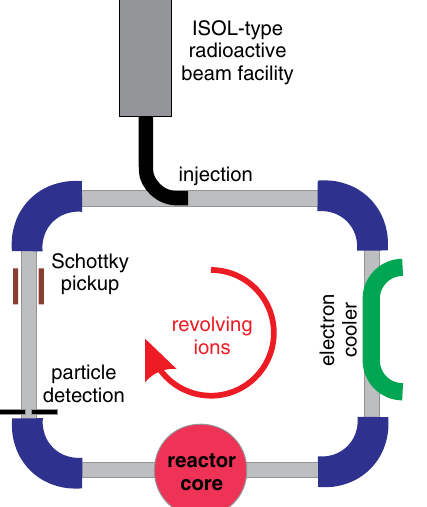
FIG. 1 (color online). Schematic drawing of the proposed setup. Shown are the facility to produce and separate exotic nuclei of interest (dark gray) and the main components of an ion storage ring which include the beam lines and focusing elements (gray), dipoles (dark blue), electron cooler (green), an intersected reactor core (red), particle detection capability (black), and Schottky pickup electrodes (brown).